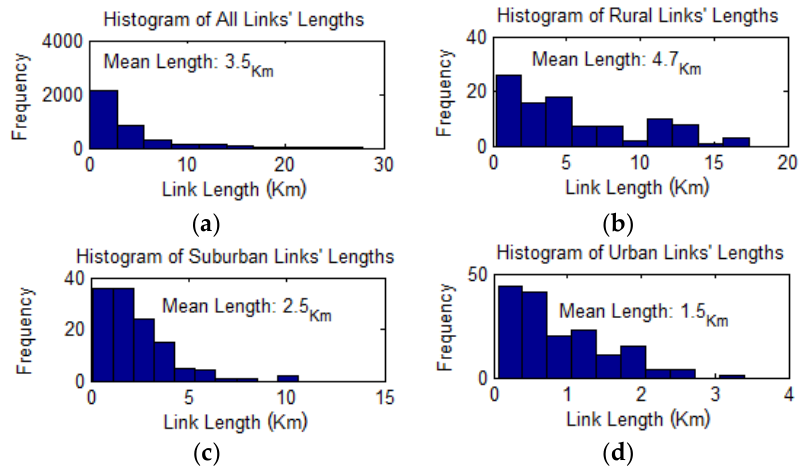
Figure 4. Lengths distributions for various environments. ( a ) all Israel, ( b ) top of northern Israel as rural, ( c ) Hasharon as suburban, ( d ) Tel Aviv as urban [6]. The sample-means specified in Figure 4 are used for the fitting of an exponential distribution.